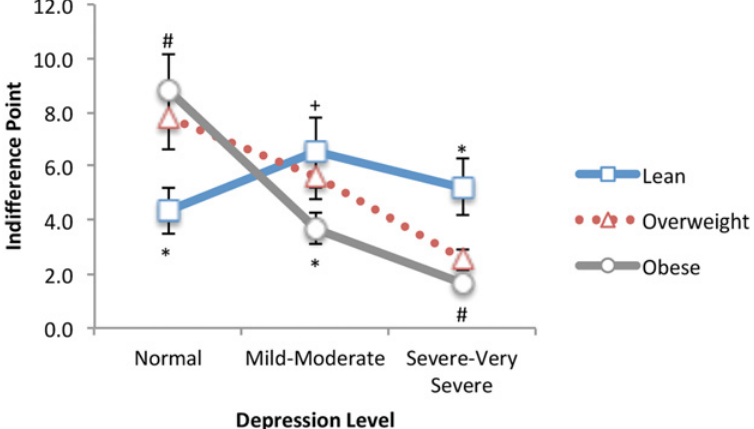
Fig 2. Dessert Food: Delay discounting as a function of BMI and depression level for a dessert food. At severe to very severe depression levels, participants who are overweight/obese show significantly greater impulsivity/lower control for a choice of a dessert food compared to lean weight participants. * Significantly different from all other groups ( p < . 01). #Significantly different from the Lean group only ( p < . 05). +Significantly different from the obese group only ( p < .